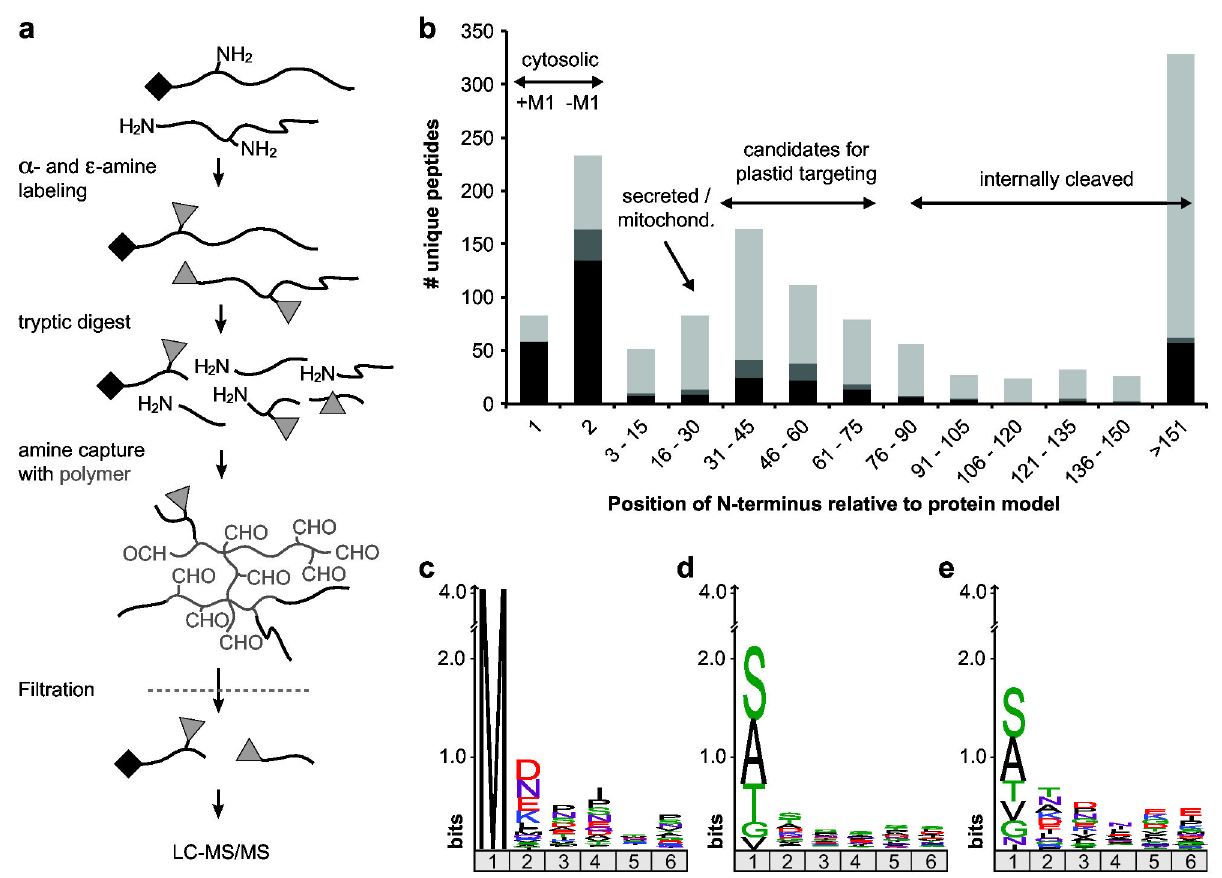
Figure 2. T. pseudonana protein termini identified by TAILS. (a) Schematic representation of the TAILS workflow. Proteins with free or naturally modified (black square) N termini are denatured, followed by chemical modification of all primary amines (grey triangle). Specific digestion with trypsin generates peptides amenable to mass spectrometric identification. N-terminal peptides are blocked, whereas internal or C-terminal peptides exhibit a trypsin-generated primary amine at their N terminus that is used to covalenty bind these peptides to an aldehyde-containing polymer which is subsequently removed by filtration. (b) Position of identified N-terminal peptides with respect to curated protein model. N termini matching the protein models at positions 1 and 2 are cytosolic proteins with intact (+M1) or removed (–M1) initiating Met. Black, acetylated N termini; dark grey, protein N termini present in both dimethylated and acetylated forms; light grey, free N termini identified as dimethylated peptides. (c) Sequence logoplot of the first 6 amino acids of 81 N termini of nuclear encoded proteins with intact initiating Met. (d) Sequence logoplot of 231 N termini of nuclear-encoded proteins starting at protein model position 2 because the initiating Met was removed. (e) Combined logoplot of N termini of 22 plastid-encoded proteins starting at position 2 after N-terminal Met excision plus 18 plastid-imported proteins with Met directly preceding the identified